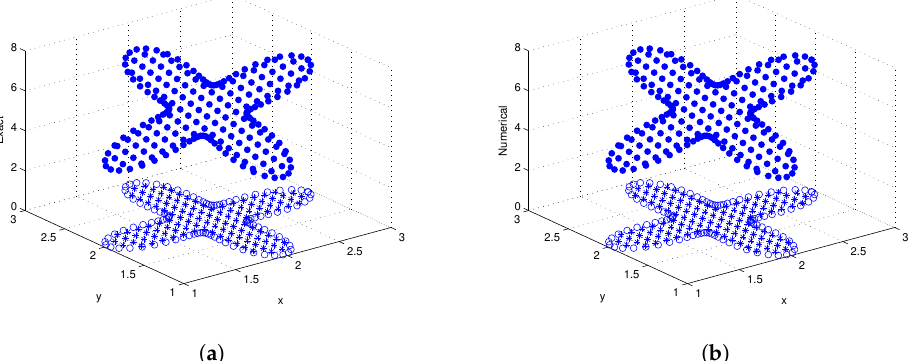
Figure 10. ( a ) Exact against ( b ) numerical solution of Cassini-shaped domain when t = 1, δ t = 0.0001, ns = 10, M = 220 to Example